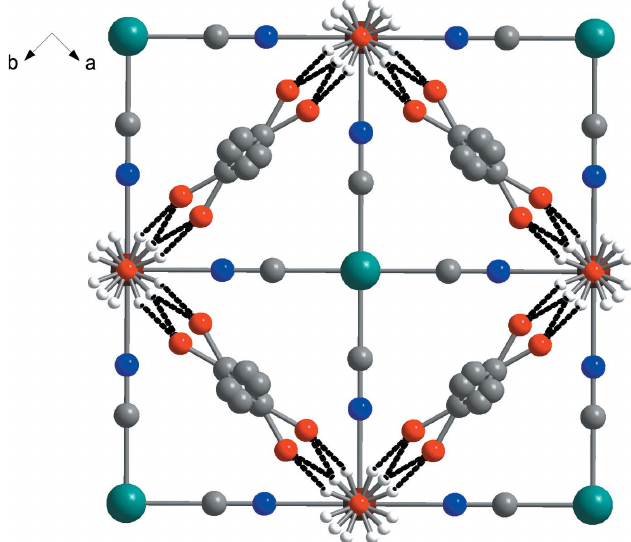
Figure 3 View of the structure of the title compound in the ab plane showing the distortion of the acetone guest molecules. Hydrogen bonds are shown as dashed lines. Acetone H atoms are omitted for clarity.